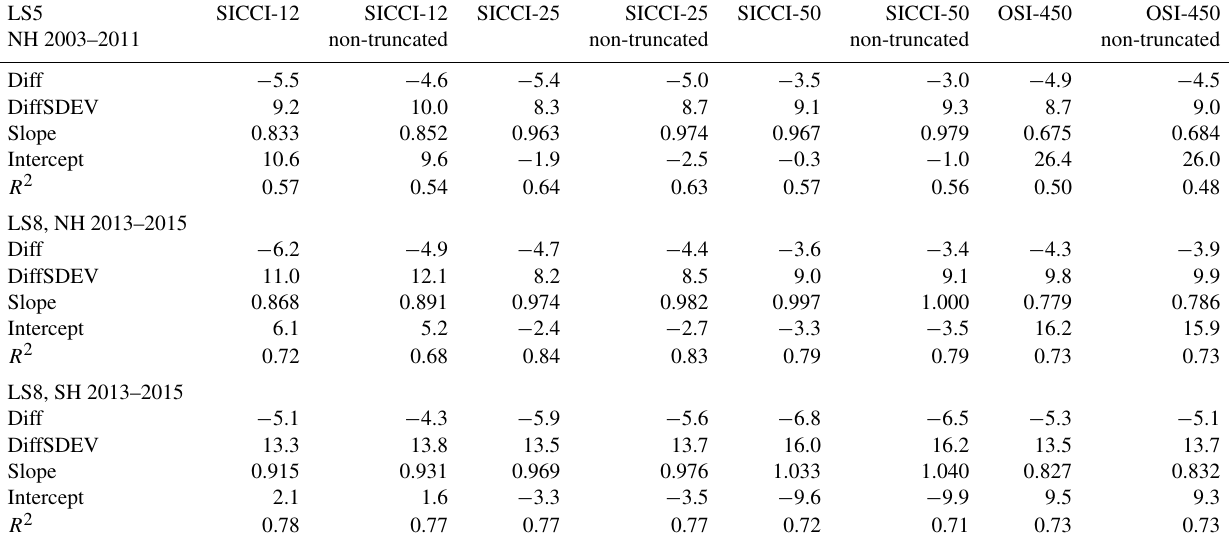
Table 8. Comparison of statistical parameters listed in Tables 5–7 in both hemispheres for SICCI-2 and OSI-450 products using truncated or non-truncated (near-100% SIC) PMW SIC data. See Table 5 for an explanation of the parameters given. Top (LS5, NH 2003–2011) is for first-year-ice-dominated cases, middle (LS8, NH 2013–2015) is for mixed first-year–multiyear and multiyear ice cases, both Northern Hemisphere, and bottom (LS8, SH 2013–2015) is for the Southern Hemisphere. The overall median differences do not change and are not listed